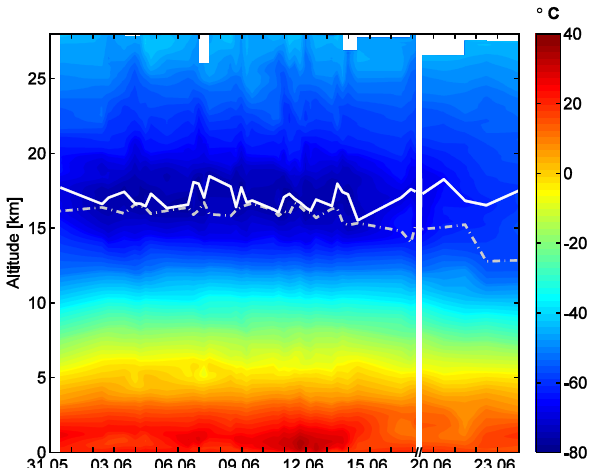
Fig. 4. Air temperature cross sections [ ◦ C] from radiosoundings for Fig. 4: Air temperature cross sections [°C] from radiosoundings for the whole cruise. Cold 677 the whole cruise. Cold point tropopause and lapse rate tropopause point tropopause and lapse rate tropopause are marked by the continuous and the dash-dotted 678 are marked by the continuous and the dash-dotted lines, respec- tively. The measurement gap between leg 2 and 3 is shortened. lines, respectively. The measurement gap between leg 2 and 3 is shortened. 679